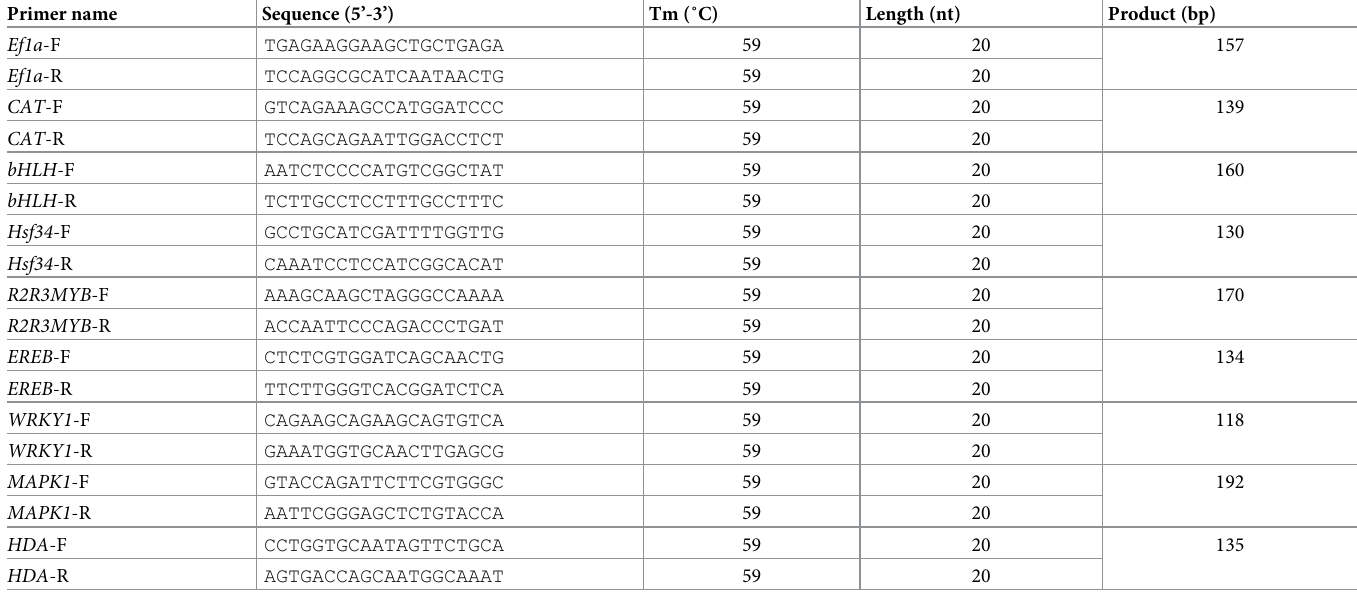
Table 1. The forward and reverse sequences of primers for target genes and Elongation factor (a housekeeping